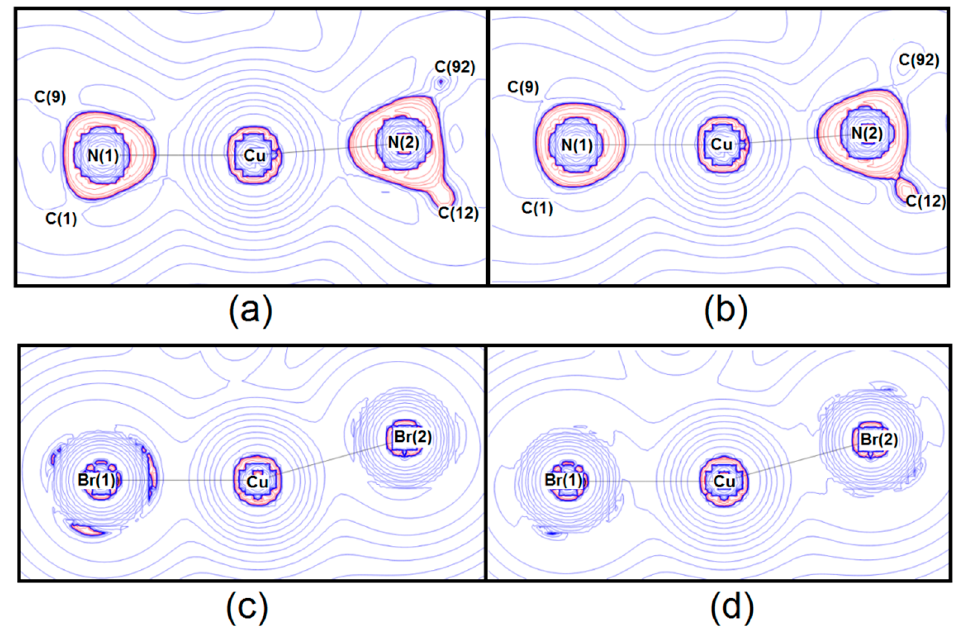
Figure 5. Isocontour maps of −∇ 2 ρ ( r ) at variable-step ( ± a · 10 − n e / A 5 , with a = 9.64, 4.82 and 2.20 and n = 0, ± 1, ± 2, ± 3, ± 4 and ± 5) in planes N(1)–Cu–N(2) ( a , b ) and Br(1)–Cu–Br(2) ( c , d ) for equatorial Cu–ligand bonds. Blue lines correspond to regions of charge depletion, while red ones indicate charge concentration. ( a , c ): Experimental multipole model; ( b , d ): multipole-projected DFT results (F theo ). Table 2. HOMED indices for aromaticity in symmetry-independent 4,7-dichloroquinoline ligands. As d orbitals on Copper are almost filled, we checked whether some kind of π -backdonation Calibration parameters proposed in [56] have been employed ( α (C = C) = 88.09 Å − 2 ; α (C = N) = 91.60 Å − 2 (Harmonic Oscillator Model of Electron Delocalization) indices [56] of 4,7-DCQ in the experimental dichloroquinoline ligand (Table 2).